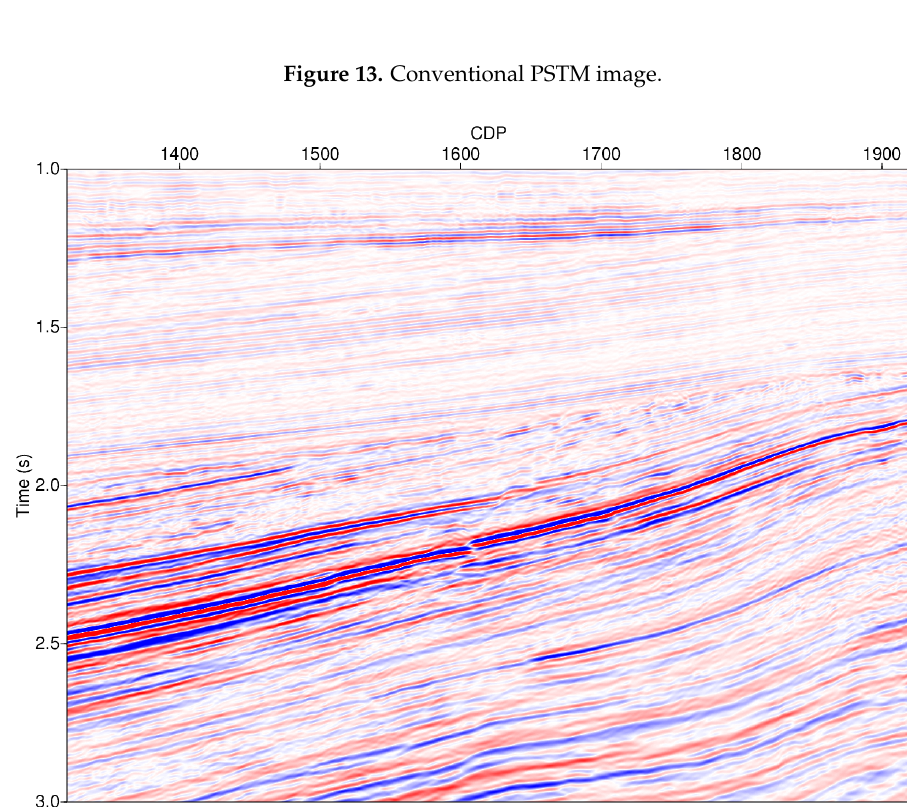
Figure 14. True high-resolution